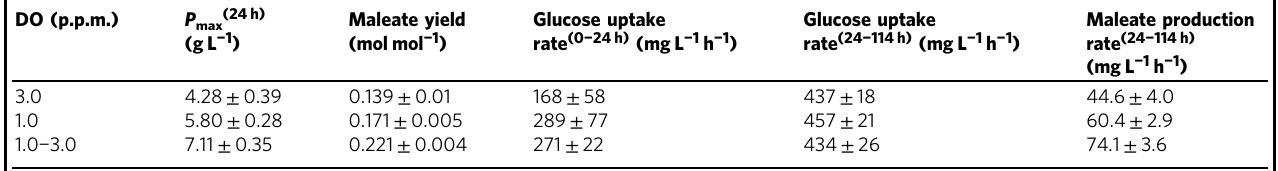
Table 2 Summary of maleate production in the culture of CMtS101 using a 1-L jar fermentor DO